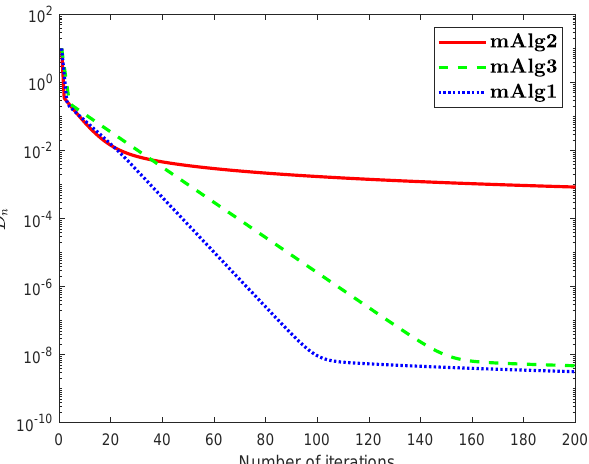
Figure 8. Algorithm 1 compared to Algorithm (60) and Algorithm 3.2 in [34] for u 0 = 1 + 2 t + 3 e t .